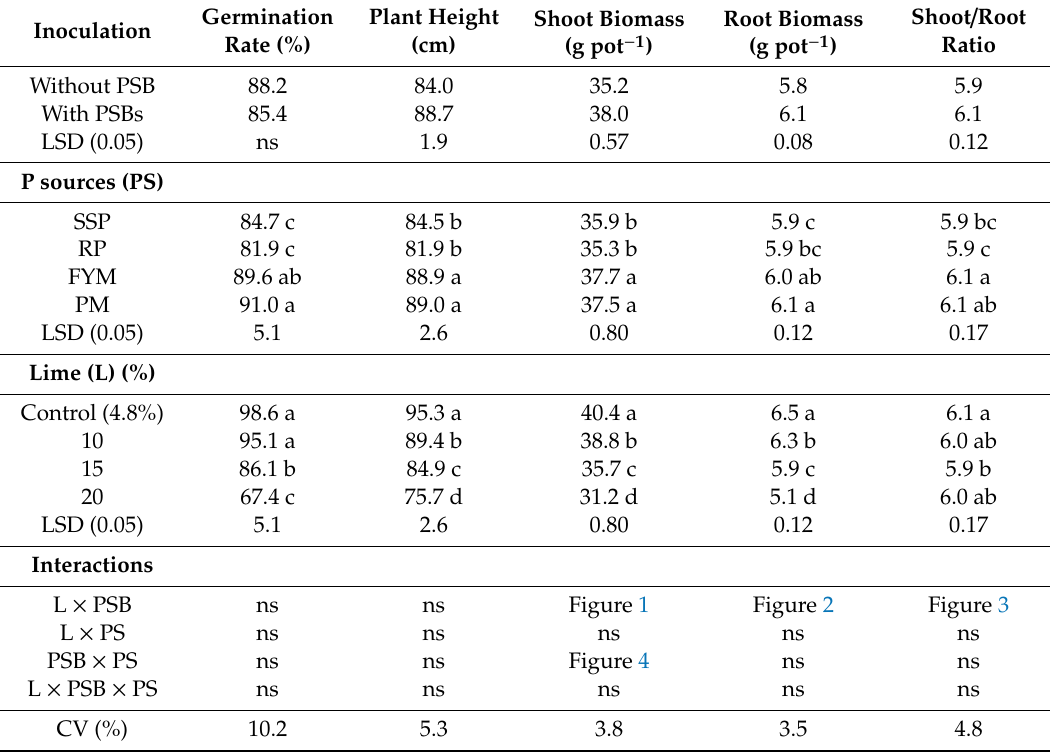
Table 4. Maize growth as a ff ected by phosphate-solubilizing bacteria (PSB) and soil phosphorus (P) sources in soil under varying levels of